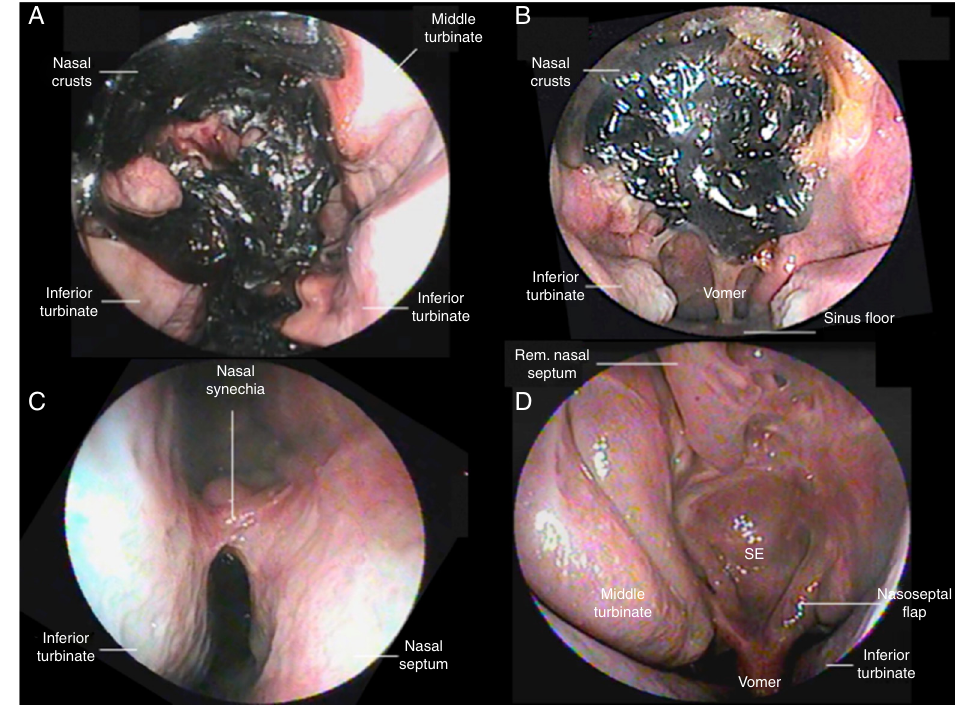
(A) and (B) Nasofibroscopy at two weeks postoperative in patients who underwent transsphenoidal surgery for pituitary adenoma, a wide number of crusts throughout the nasal cavity can be observed. It is not possible to observe the sphenoid sinus and sellar regions. No manipulation is performed in the surgical area due to the risk of manipulation of nasoseptal flap, which can result in a cerebrospinal fluid leak. (C) The right nasal fossa synechia can be observed between the inferior turbinate and the nasal septum, in the postoperative period of three months; (D) six months postoperative of pituitary adenoma, in which various anatomical structures can be identified, including the right middle turbinate as the nasoseptal flap was made to the left (the beginning of flap within the sphenoid sinus floor can be observed), with removal of the ipsilateral middle turbinate as the patient had a significant septal deviation to the right. It is also possible to observe the sphenoid region wide open and completely covered by the flap; it is possible to identify the upper portion of the nasal septum, as the nasal septum was removed (preserving the area K, Keystone, and 1 cm from the nasal septum